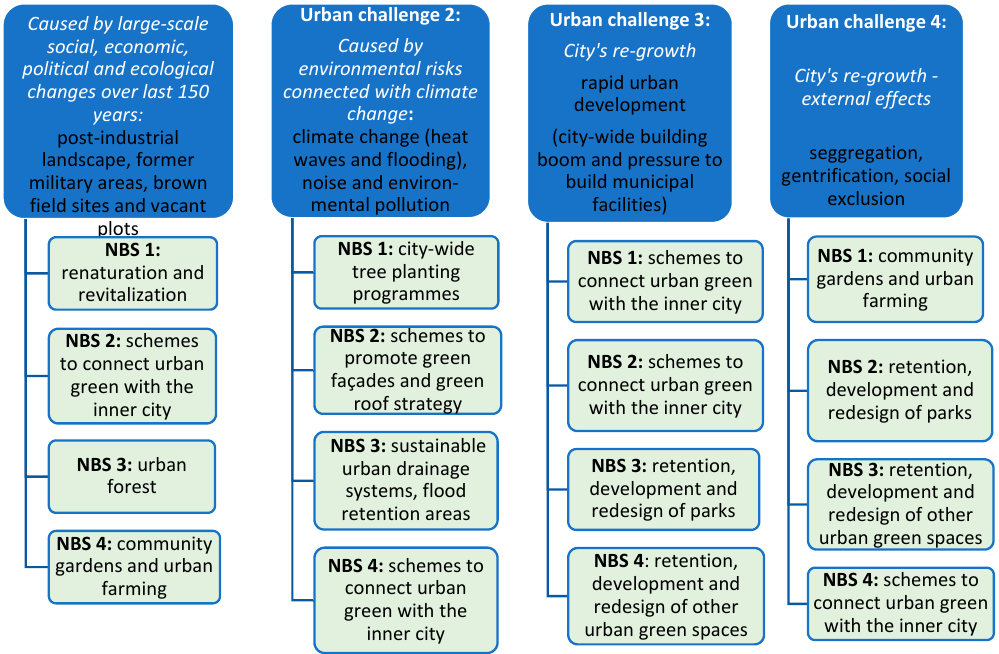
Figure 2. Current major sustainability challenges systematized for the city of Leipzig and related to the nature-based solutions (NBSs) that are the focus of this study (source: authors).